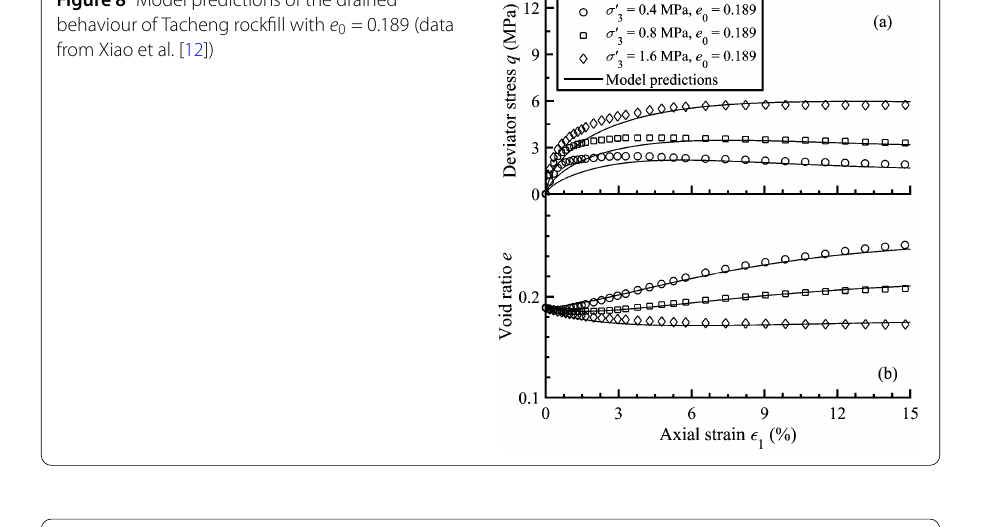
Figure 9 Model predictions of the drained behaviour of Tacheng rockfill with e 0 = 0.244 (data from Xiao et al.